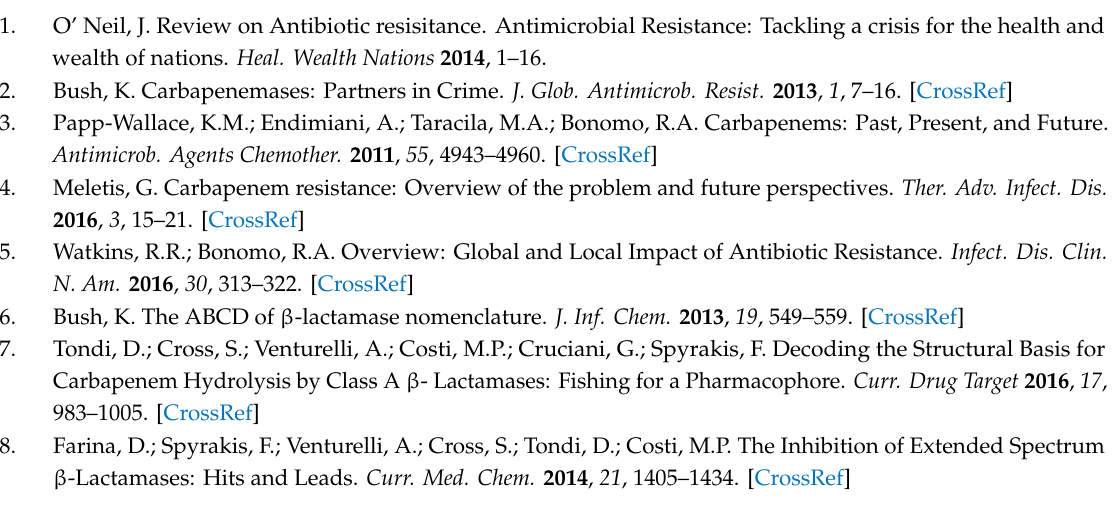
of charge. Table S1: Statistics of data collection, processing and refinement, Table S2: Hydrogen bonds between ligand molecule 3, PaAmpC residues and water molecules, Figure S1: Key interactions PA AmpC: 3 , Figure S2. Overlay of the EcAmpC: ceftazidime and PaAmpC: 3 active sites, Figure S3. Overlay of the KPC-2: